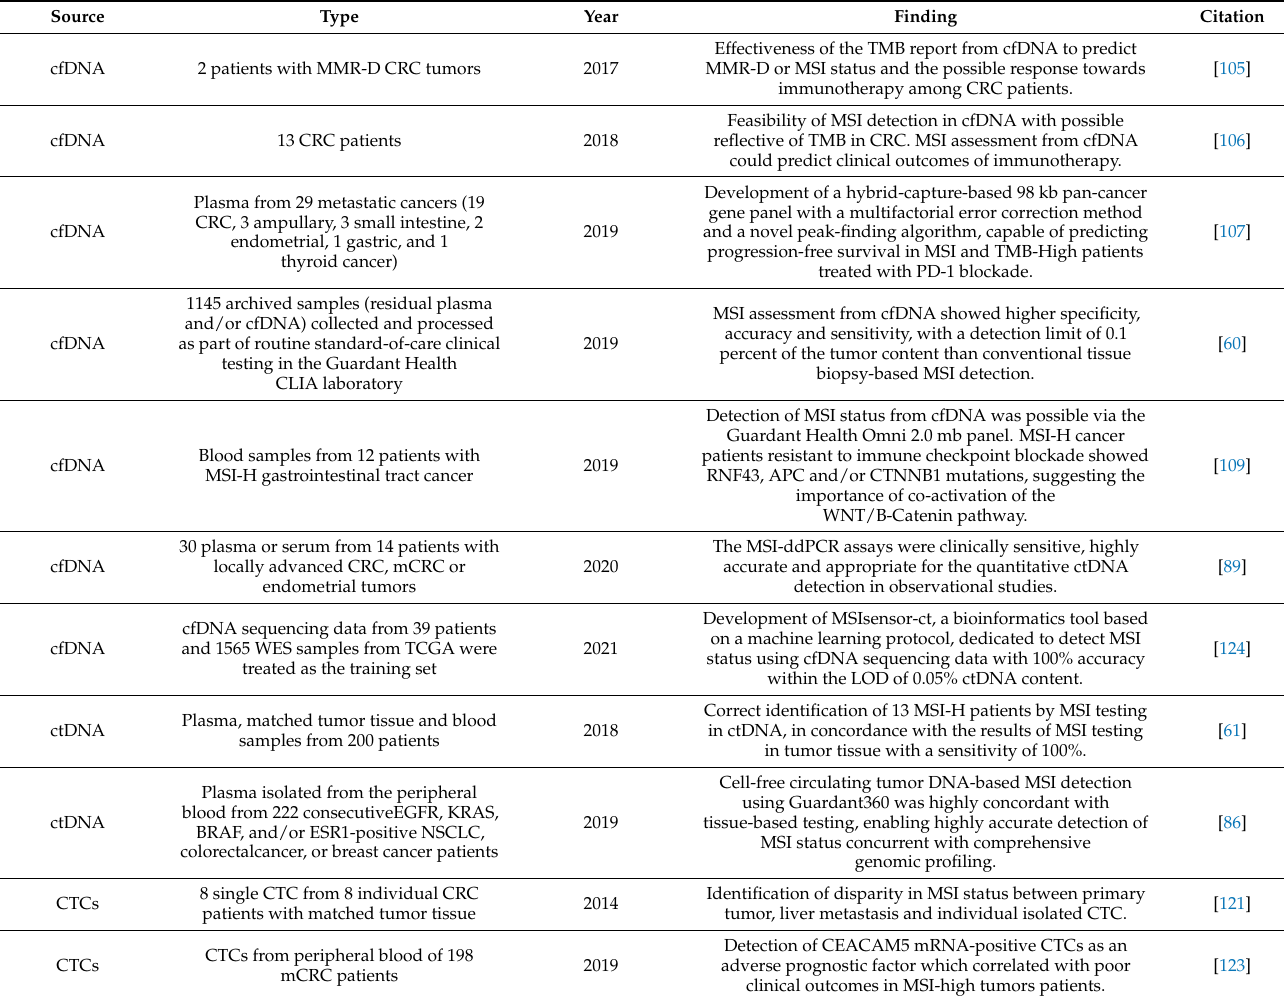
Table 1. Summary of recent findings of MSI in cfDNA, ctDNA and CTCs from